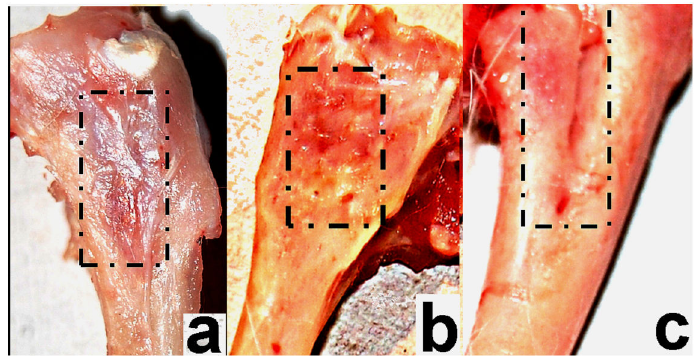
Figure 2. Gross observations of defect site after week 25 (a) treated with n-HA/gel/CMC with adherent soft tissue, (b) after removal of soft tissue, showed ultimate scar-free closure of the cortical window and (c) of SHAM operated site. doi: